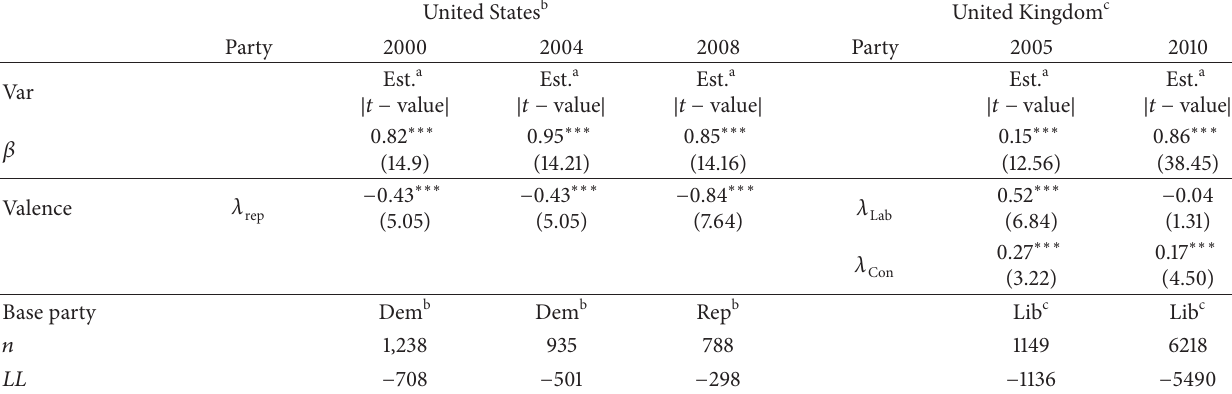
Table 1: MNL spatial model for countries with plurality systems.